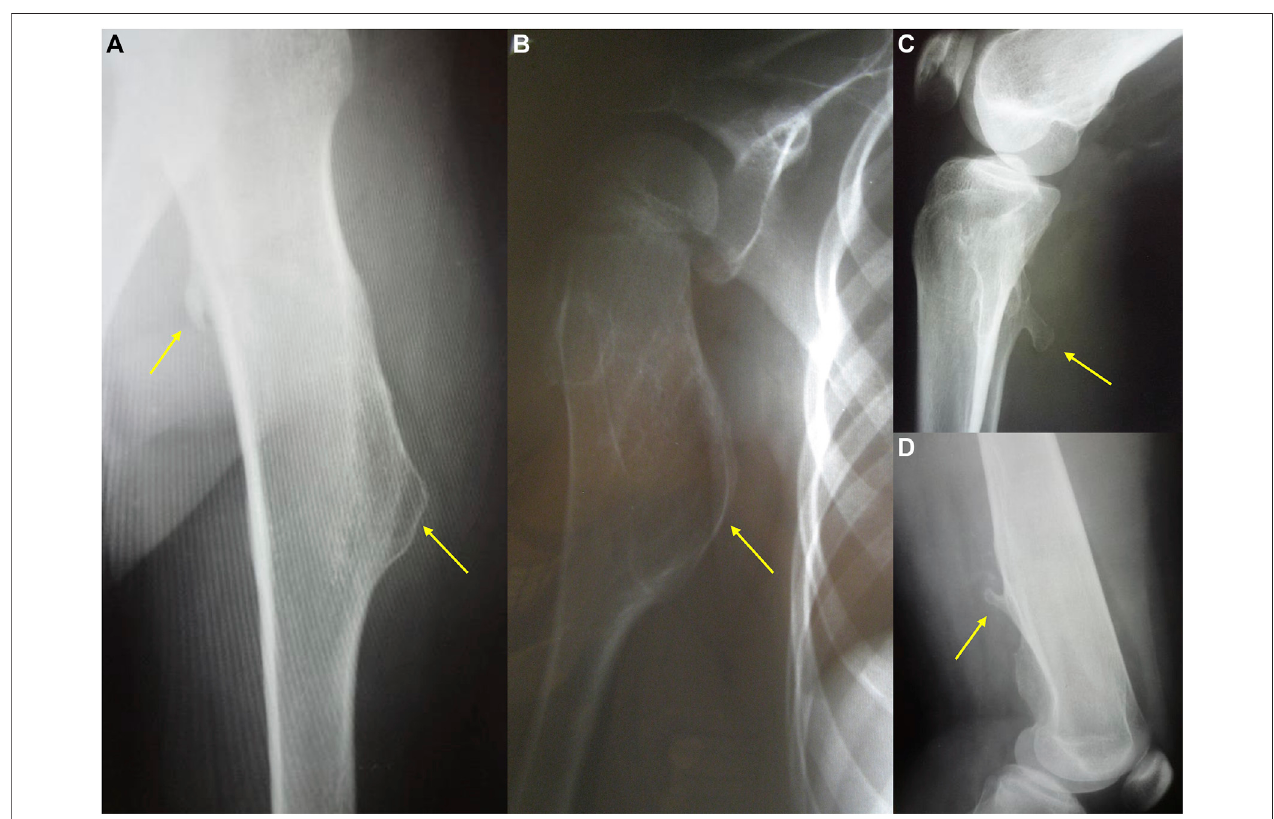
FIGURE 1 | The radiography showing two different types of exostoses. Pictures (a,b) present sessile, mound shape osteochondromas, while (c,d) show pedunculated exostoses.